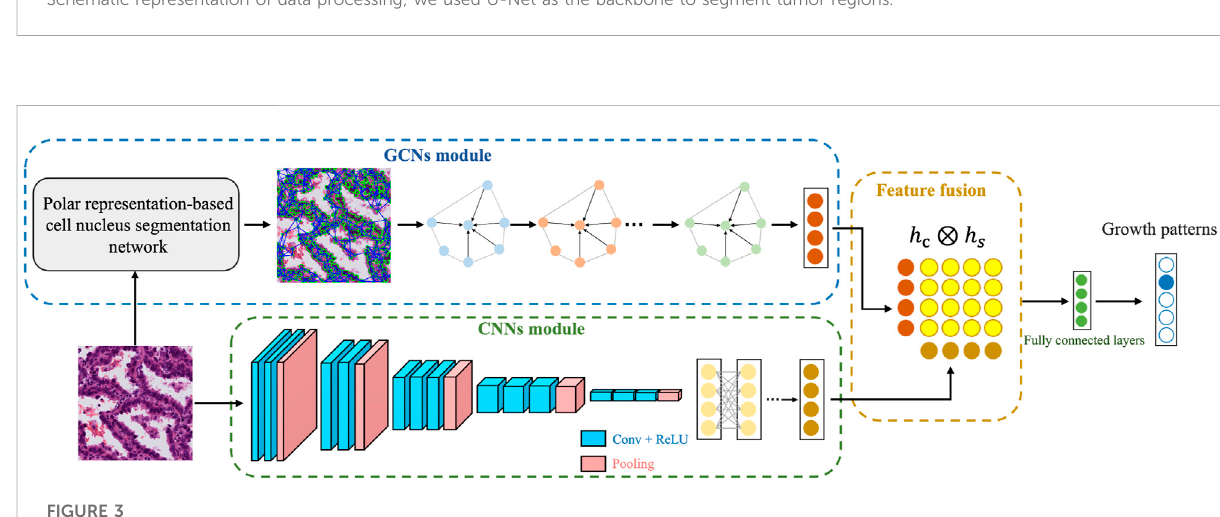
FIGURE 2 Schematic representation of data processing; we used U-Net as the backbone to segment tumor regions.